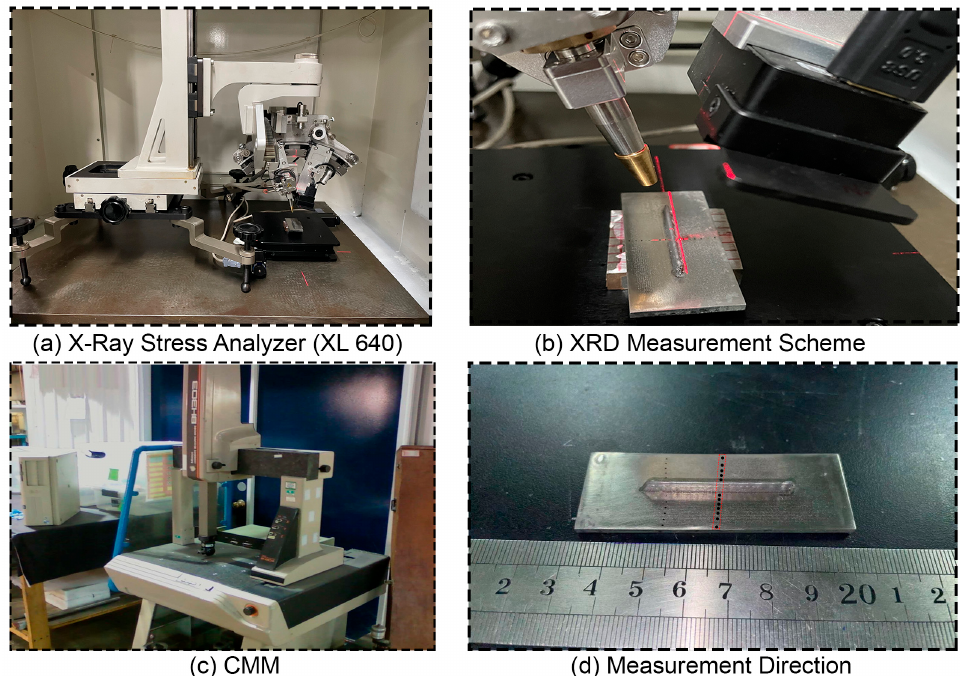
Figure 3. Experimental illustration for residual stress and distortion